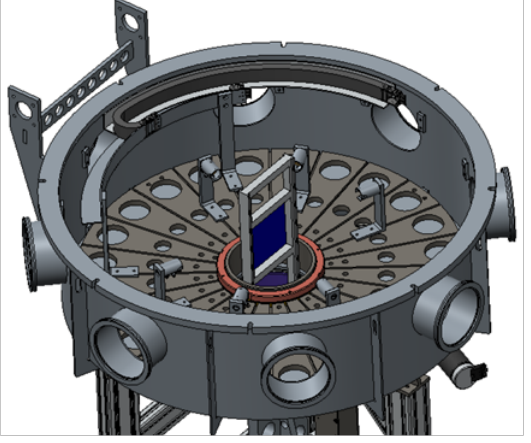
Figure 5. Scintillator response at given time / energy Figure 7. Simulated neutron spectrum (empty squares), TOF data (line) and simplified deconvolution of proton-recoil spec- trum (full squares)